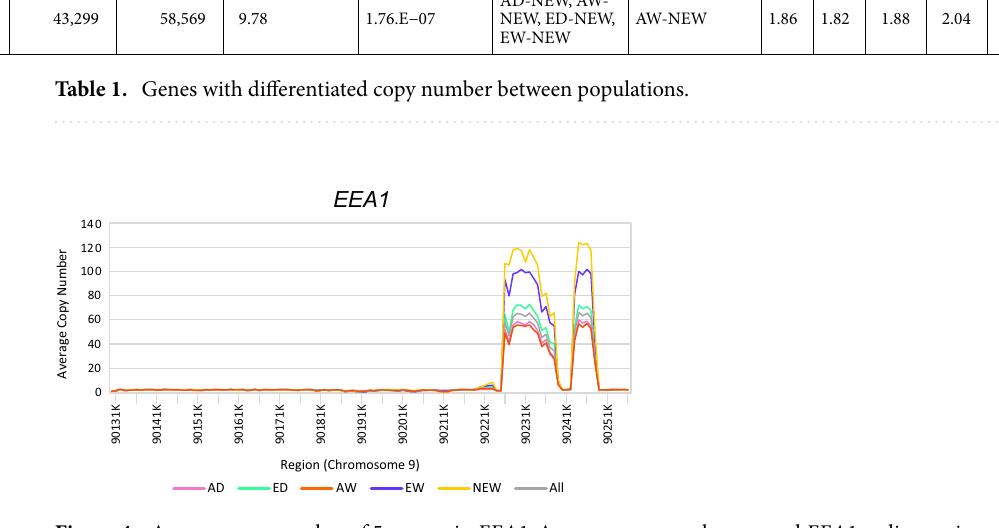
Figure 4. Average copy number of 5 groups in EEA1 . Average copy number around EEA1 coding region. X-axis indicated genomic region and y-axis indicated average copy number in each group. EEA1 located from 90,131,707 to 90,257,014 in chromosome 5 and the average copy number of every 1000bp regions from 90,131,001 to 90,258,000 were visualized as a line graph. The two peak regions were 90,227,001–90,240,000 and